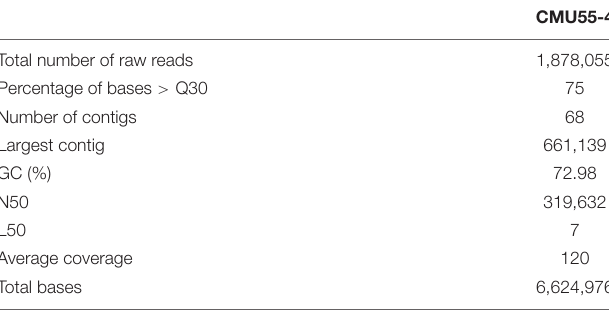
TABLE 3 | Summary of sequence reads assembly of strain